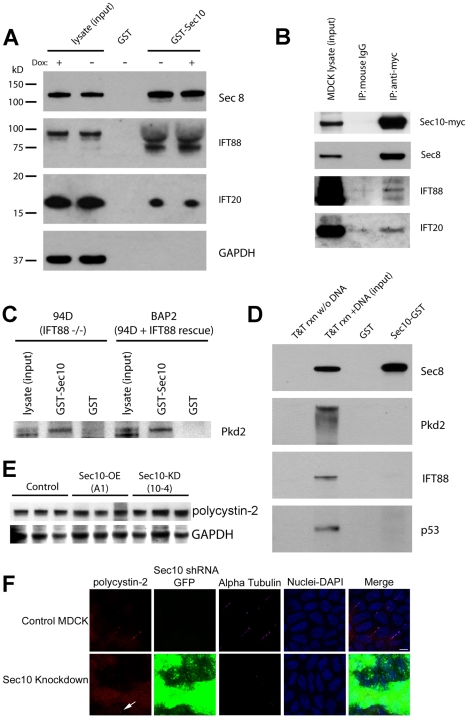
Sec10 interacts with IFT88 and IFT20.(A) After incubation with HEK293 cell lysate, Sec10-GST, but not GST
alone, pulled down the cilia transport proteins IFT88 and IFT20. As a
positive control for exocyst binding, Sec8 is shown to bind to
Sec10-GST. To demonstrate specificity for the pulldown products, we
blotted for GAPDH, a house-keeping protein not known to interact with
the exocyst. GAPDH was identified only in cell lysate, and not in
pulldown fractions. (B) IFT88 and IFT20 co-immunoprecipitated with
Sec10, but not isotype controls, from lysates of ciliated MDCK cells
expressing a myc epitope-tagged Sec10. (C) To determine if IFT88 was
necessary for the interaction between polycystin-2 and Sec10, Sec10-GST
pulldowns were performed using lysate from both IFT88-deficient (94D),
and IFT88-replete (BAP2) cell lines. There was no difference in the
amount of polycystin-2 pulled down from the IFT-deficient or -replete
cell lines. (D) In vitro translation of Sec8,
polycystin-2, IFT88, and p53, followed by Sec10-GST pulldown, was also
performed and an interaction was only detected between Sec8 and Sec10.
This suggests that the Sec10/polycystin-2 and Sec10/IFT88 interactions
are indirect. (E) Equal amounts of polycystin-2 protein, as determined
by Western blot, are seen in control (T23), Sec10-overexpressing (A1),
and Sec10 knockdown (10-4) MDCK cells. GAPDH staining is presented as a
loading control. (F) Immunofluorescence staining, using a monoclonal
antibody against acetylated alpha tubulin, that is specific for primary
cilia (purple), and a polyclonal antibody against polycystin-2 (red),
demonstrated co-localization of polycystin-2 at the primary cilia in
control cells. As we previously reported [39], no, or few, primary
cilia were seen in Sec10 knockdown cells, and the polycystin-2 appeared
to be widely dispersed inside these cells. We occasionally saw
concentrated polycystin-2 at what appeared to be the basal body or
primary cilium (arrow); however, this occurred in cells demonstrating
lower or no GFP expression, indicating a lack of Sec10 knockdown in
those cells. The images presented are all X-Y sections, and were
obtained using the same confocal settings. Please note that the DAPI
staining for the cell nuclei was captured at a different level in the
cell than the other sections and is included in the merge to delineate
cell boundaries. Bar = 5 μm.